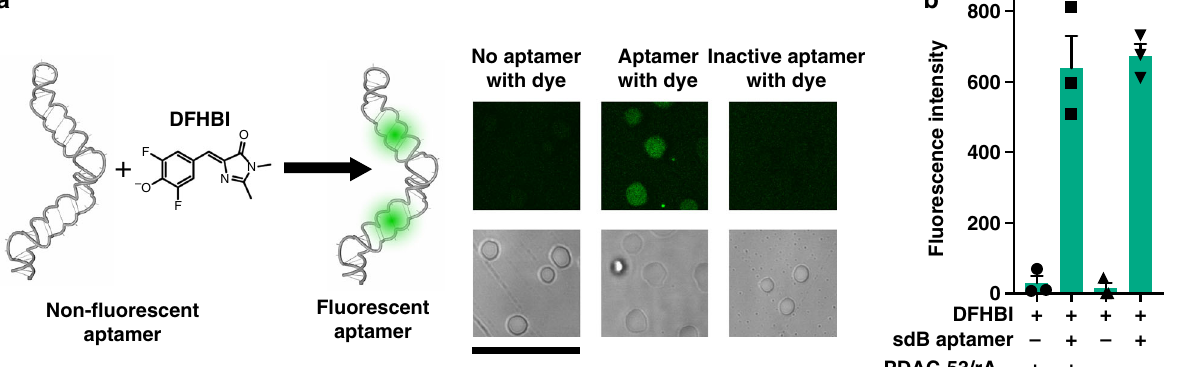
Fig. 4 Active RNA aptamer folding inside PDAC/rA 11 coacervates. a (Left) Model of stabilized dimeric broccoli (sdB) RNA drawn in NUPACK 55, and confocal microscopy images (right) of PDAC-53/rA 11 coacervates containing sdB RNA complexed with DFHBI dye. No fl uorescence is seen when coacervates contain only DFHBI dye or an inactive mutant of the aptamer. Coacervates contained 100 nM sdB RNA and 10 µ M DFHBI in 25 mM Tris pH 8.0, 5 mM MgCl 2 and 5 mM KCl. 488 nm laser was used for excitation and emission window was 500 – 550 nm. Scale bar is 20 µ m. b Bulk fl uorescence measurement of sdB RNA aptamer in the presence and absence of PDAC-53/rA 11 coacervates. Error bars represent S.E.M. ( n = 3) from three